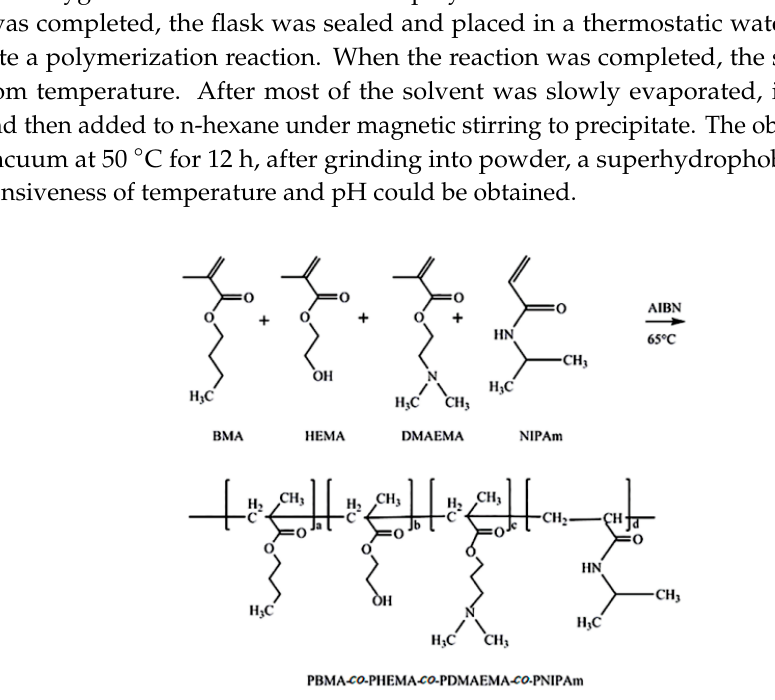
Figure 1. The synthesis route of PBMA- co -PHEMA- co -PDMAEMA- co -PNIPAm.